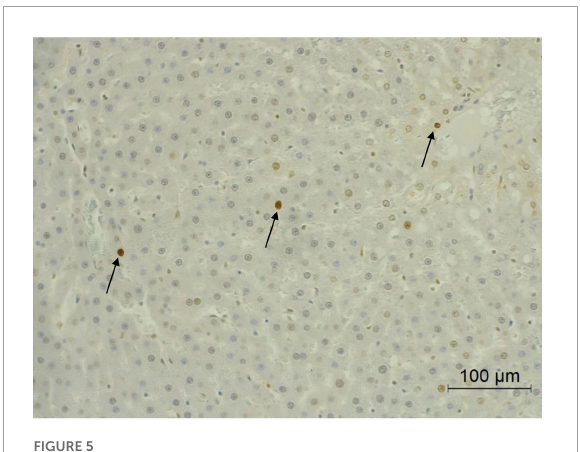
FIGURE5 Apoptotic hepatocytes in liver tissue. Black arrow represents apoptotic hepatocytes.